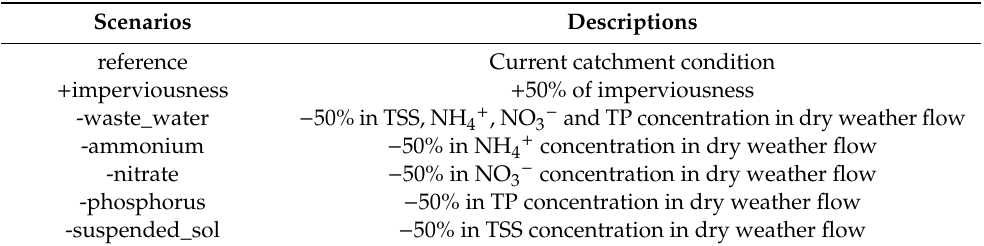
Table 4. Description of catchment change scenarios.